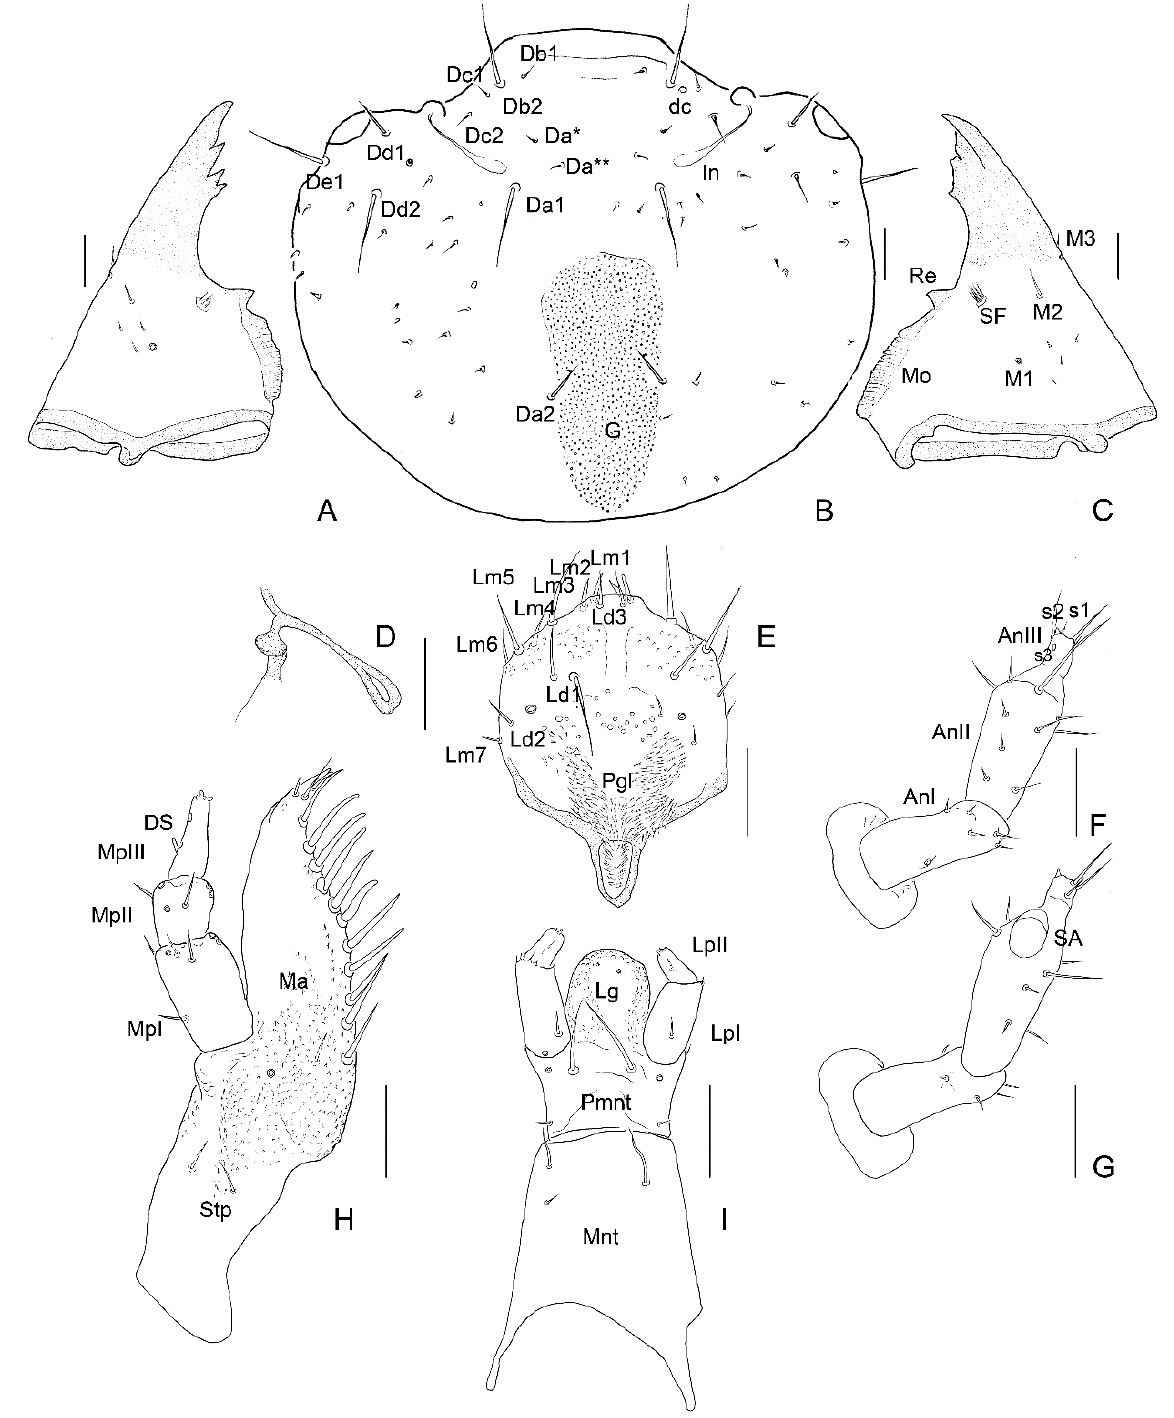
Figure 5. Leiodes cinnamomea . Details of larval morphology of instar II. ( A ) Left mandible, ventral view. ( B ) Dorsal side of head. ( C ) Right mandible, ventral view. ( D ) Sclerotized invagination of head. ( E ) Labrum, ventral view. ( F ) Antenna, dorsal side. ( G ) Antenna, ventral side. ( H ) Maxilla, ventral view. ( I ) Labium, ventral view. Abbreviations: AnI, AnII, AnIII—antennomere I, II, III; SA— sensory appendage: Cdo—cardo; DS—digitiform sensillum; G—granulation; In—invagination; LpI, LpII—labial palpi segment I, II; Lg—ligula; Ma—mala; Mnt—mentum; Mo—mola; MpI, MpII, MpIII—maxillary palpi segment I, II, III; Pgl—paraglossae; Pmnt—prementum; Re—retinaculum; SF—setal field; Stp—stipes. The other abbreviations refer to the terminology of setae. Scale bars = 0.1 mm.